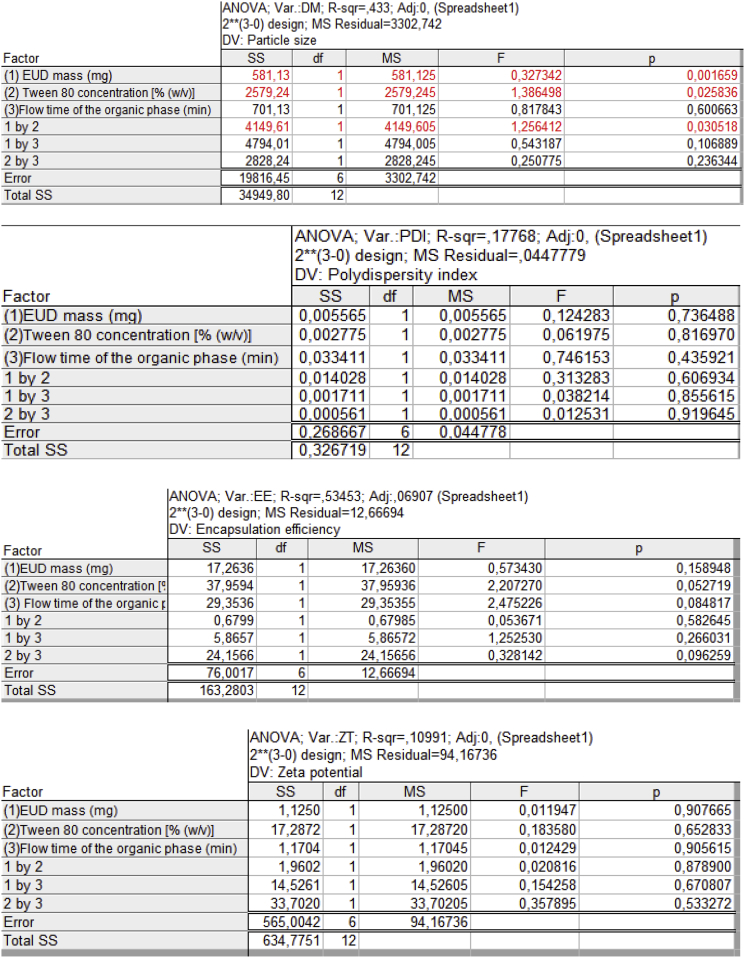
Original data exported from the Statistica v7.0.61.0 EN software to obtain data described in Table 2.